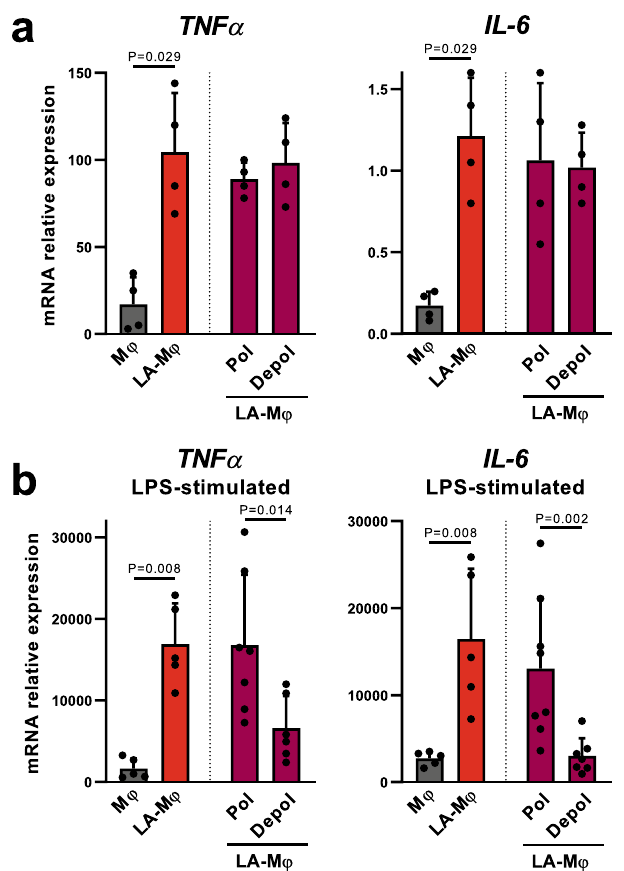
Fig. 5 Relative expression of cytokine mRNAs by LA-M φ with depolarized mitochondria. a , b Monocytes were polarized into macrophages by incubation in the absence (M φ ) or presence of lactic acid (LA-M φ ) for 3 days. LA-M φ with and without depolarized mitochondrial membranes ( “ Depol ” and “ Pol ” populations, respectively) were sorted by fl ow cytometry with MitoTracker probes. Cells were unstimulated ( a ) or stimulated with LPS for 3 h ( b ) and the levels of TNF α and IL-6 mRNA were assessed by RT-qPCR. The results were expressed as mRNA levels relative to those for the housekeeping gene RPS18 (mean ± SD, a n = 4; b n = 5 for M φ and LA-M φ ; n = 7 for “ Depol ” and “ Pol ” populations). A two-tailed Mann – Whitney U test was performed for statistical analysis. Source data are provided in a Source Data fi